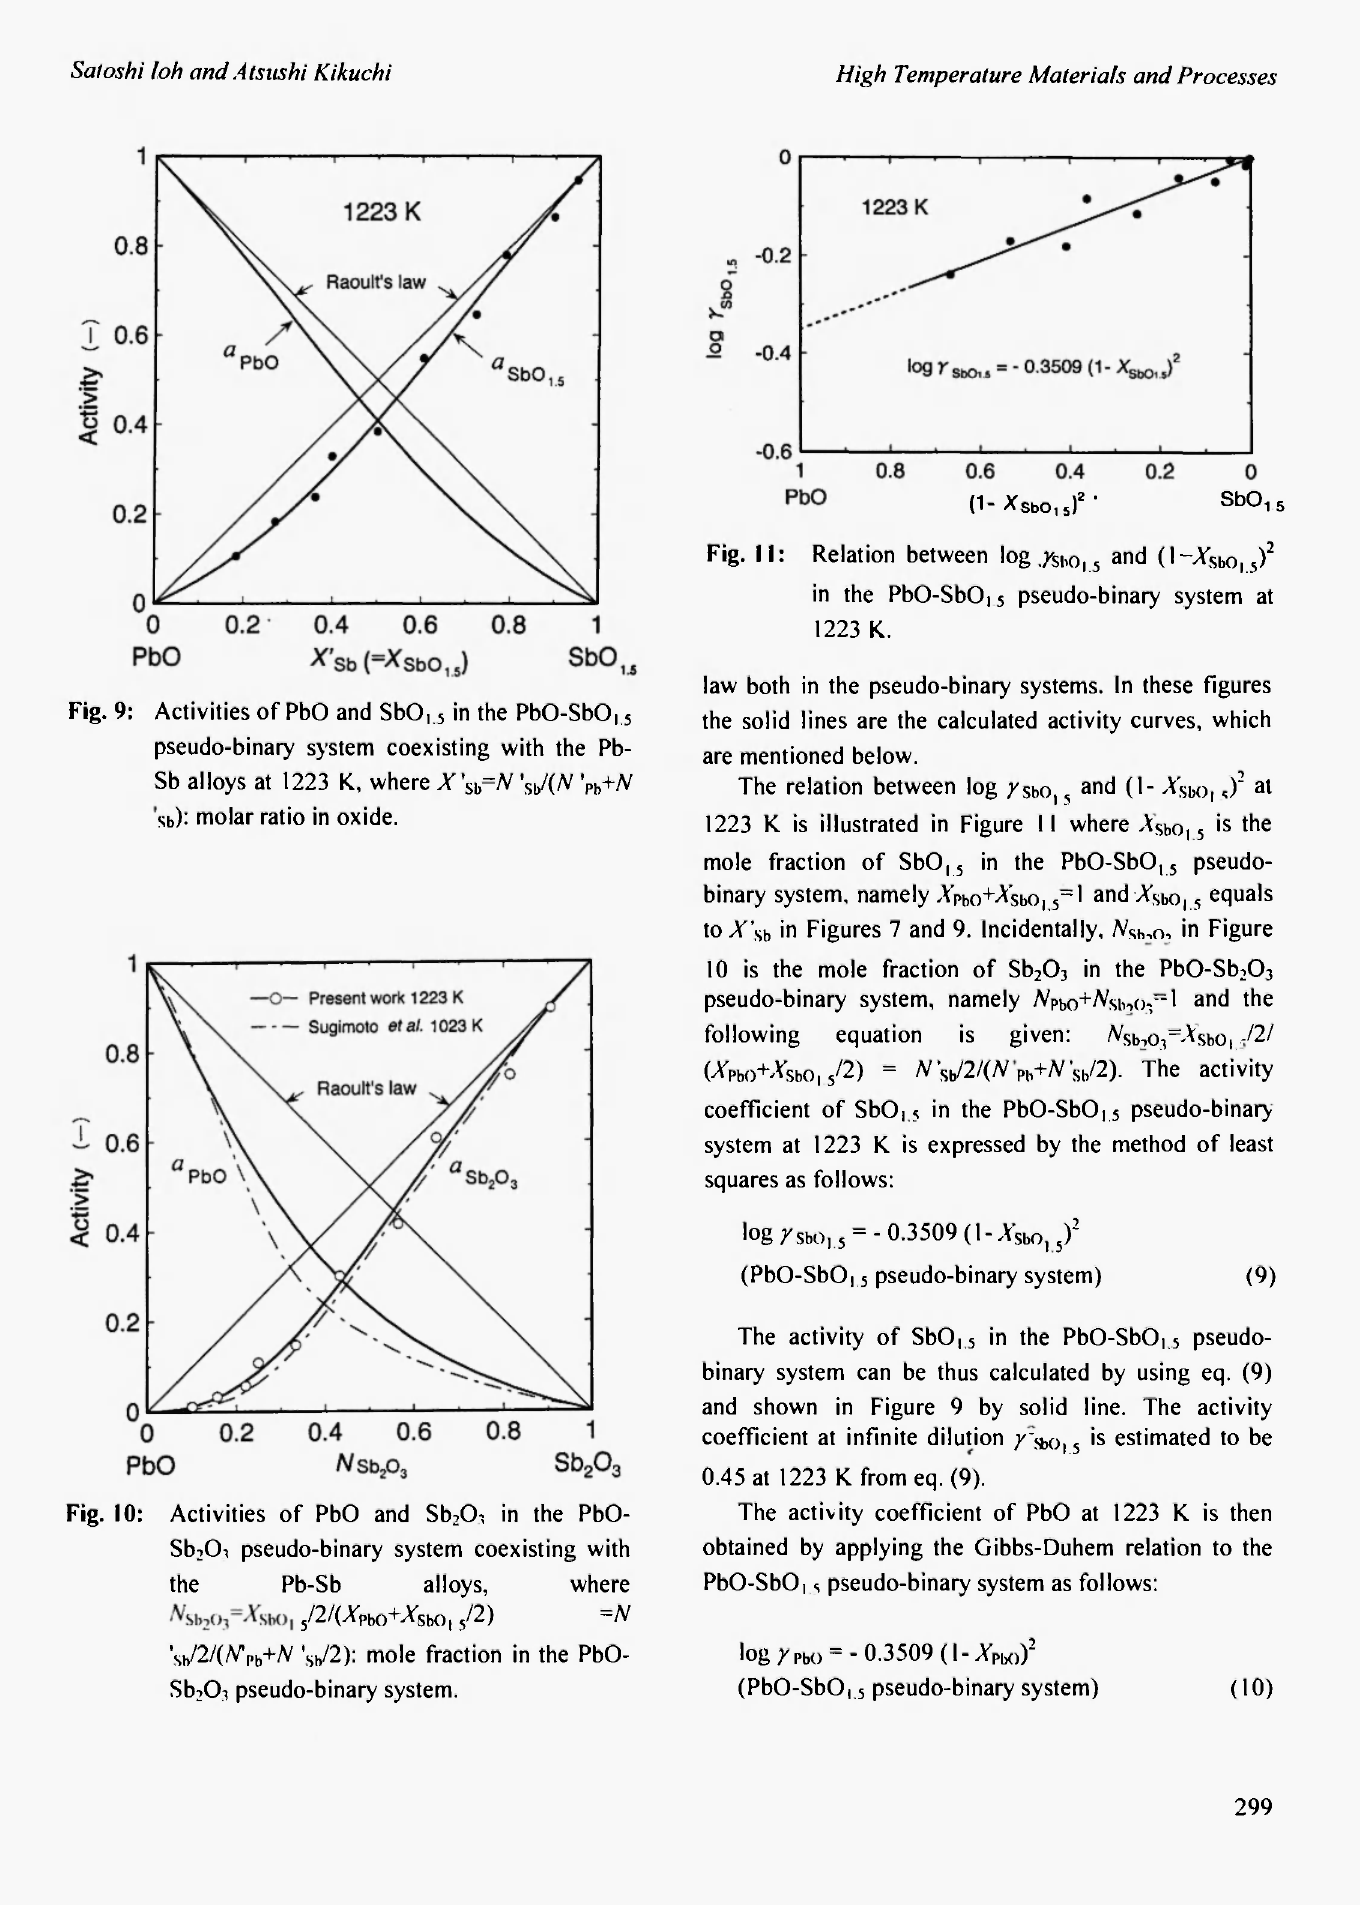
Fig. 10: Activities of PbO and Sb 2 Oi in the PbO- Sb 2 Oi pseudo-binary system coexisting with the Pb-Sb alloys, where 5 /2/(jr Pb o+jrsbo l5 /2) =N , sh/2/(A^p b +A' ' sh /2): mole fraction in the PbO- Sb 2 0 3 pseudo-binary system.